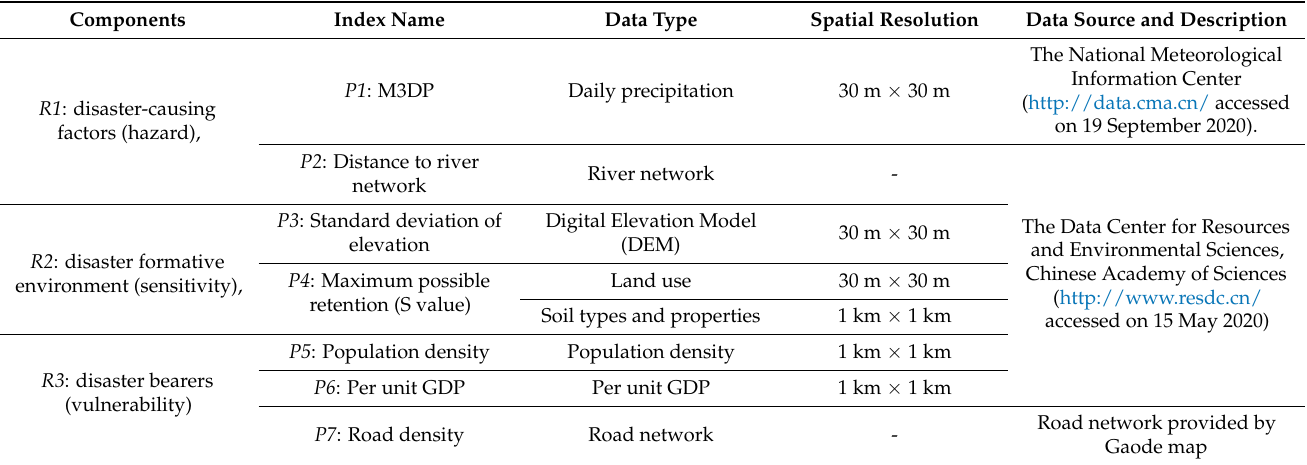
Table 1. The data sources for the seven indices.